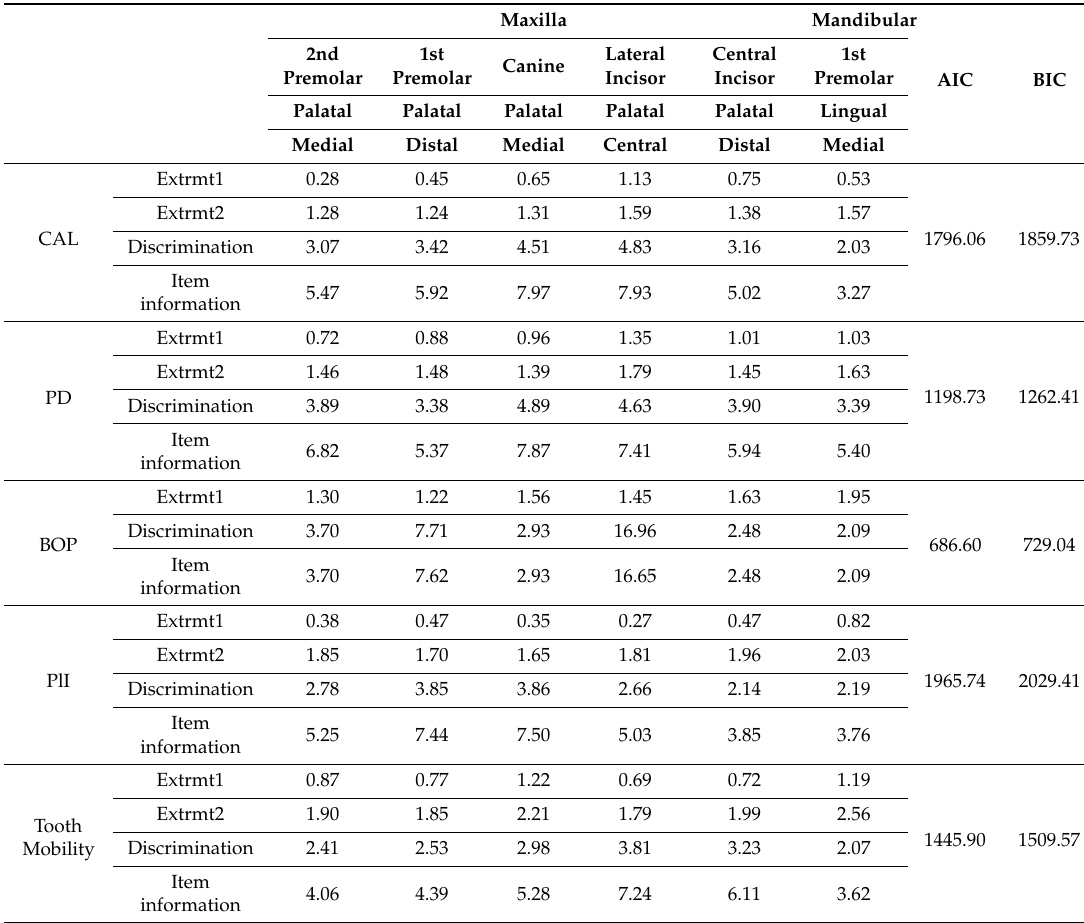
Table 1. Final model (Model 4) for the clinical attachment